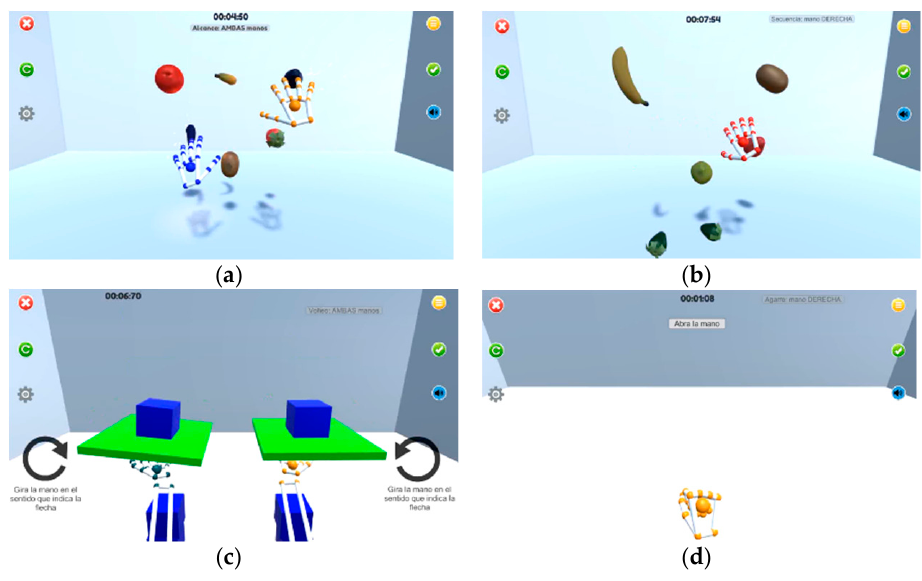
Figure 1. ( a ) Reach game; ( b ) Sequence game; ( c ) Flip game; ( d ) Opening/closing game.